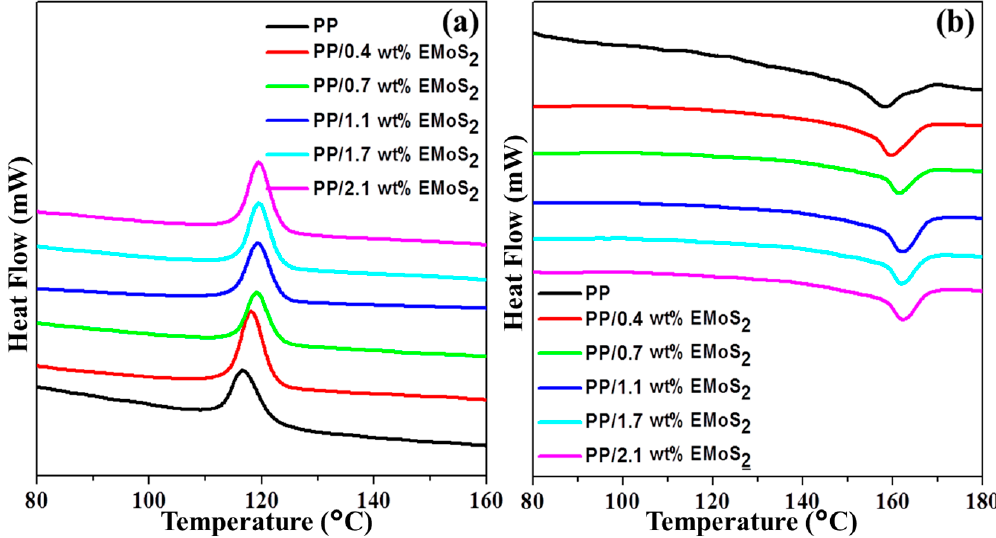
Figure 5. DSC ( a ) cooling and ( b ) heating curves of PP and PP/EMoS 2 nanocomposites with different EMoS 2 contents.